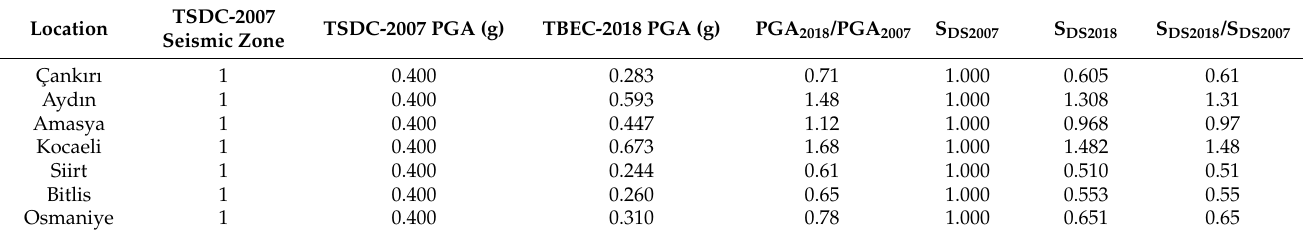
Table 5. PGA and S DS values and comparison over the last two